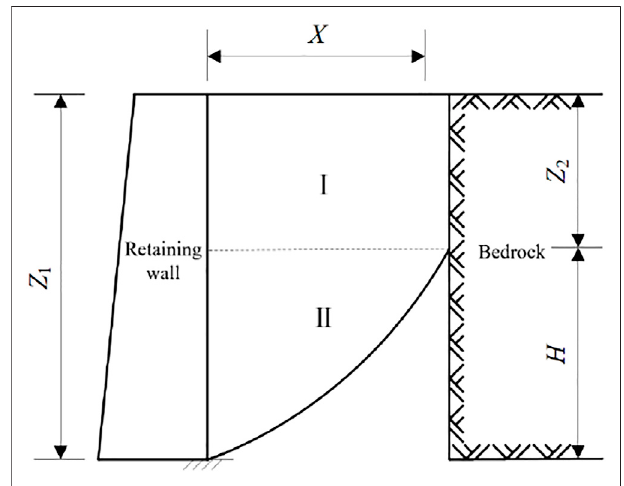
FIGURE 1 | Mechanical model of earth